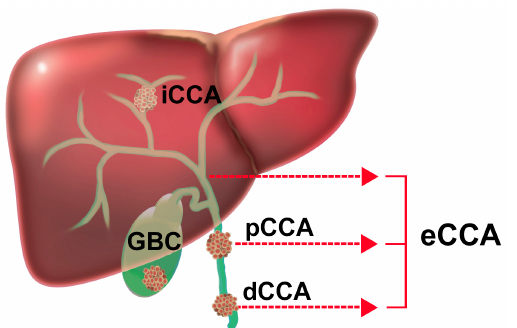
Figure 1. Schematic figure representing biliary tract cancer anatomical subgroups. Abbreviations: eCCA, extrahepatic cholangiocarcinoma; dCCA, distal cholangiocarcinoma; pCCA, perihilar cholan- giocarcinoma; iCCA, intrahepatic cholangiocarcinoma; GBC, gallbladder cancer; ICI, immunocheck- point